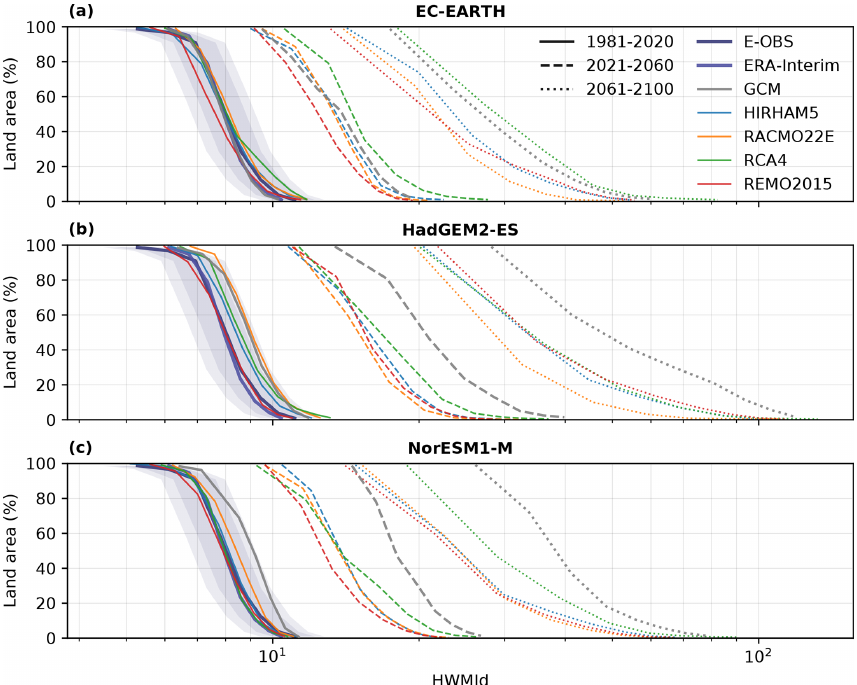
Figure 9. Percentage of the land area exceeding certain HWMId levels during the defined three periods (identified by the line styles), grouped by the driving GCMs: (a) EC-EARTH, (b) HadGEM2-ES, and (c) NorESM1-M. Colors represent different RCMs and gray the GCMs themselves. Data from E-OBS and ERA-Interim are also shown for comparison under the recent past climate. The shaded areas indicate within ± 10% (relatively dark) and ± 15% (light) of E-OBS data. Note that a logarithmic-scale x -axis is